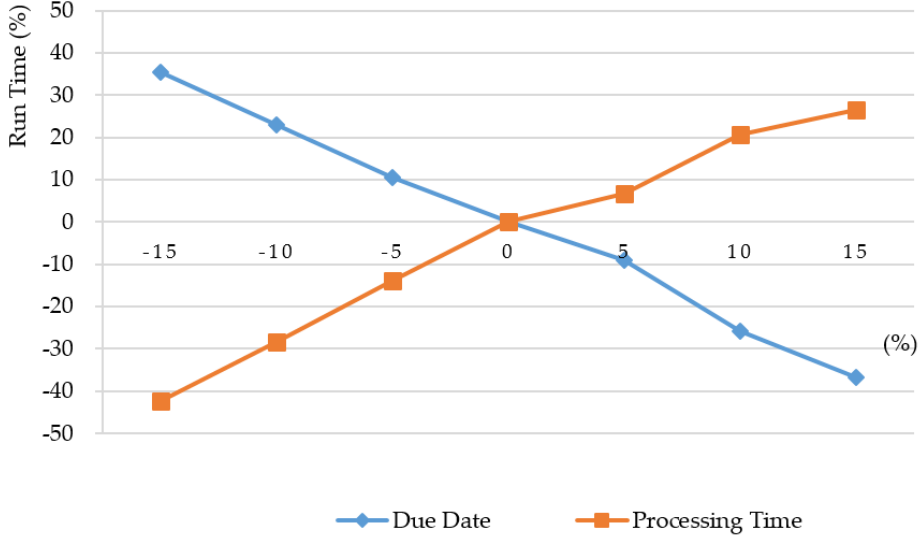
p and d on run time. Figure 4. The influences of p j and d j on run time. j j